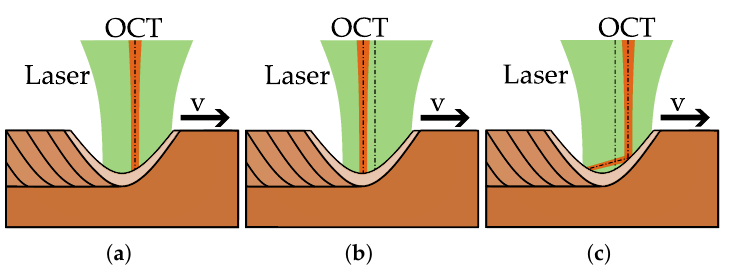
Figure 4. Schematic illustration of the optical coherence tomography (OCT) beam position relative to the capillary and the laser beam origin, ( a ) OCT beam aligned with laser beam, insufficient depth measurement; ( b ) OCT beam shifted to the deepest point of the capillary, true capillary depth measurement; ( c ) OCT beam reflected on the capillary surface, depth measurement too